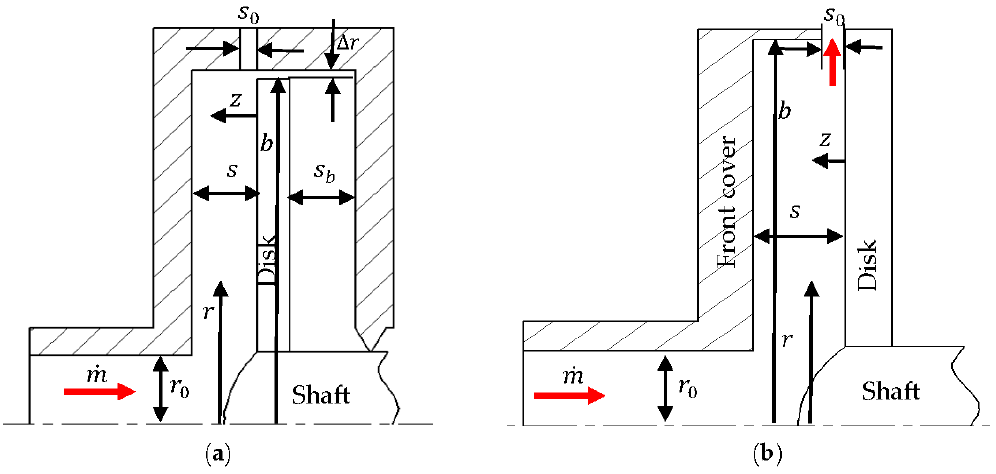
Figure 2. Sketch maps of the test rigs (not to scale): ( a ) SRSCA and ( b ) SRSCB. Table 1. Main parameters of the test rigs in this study.